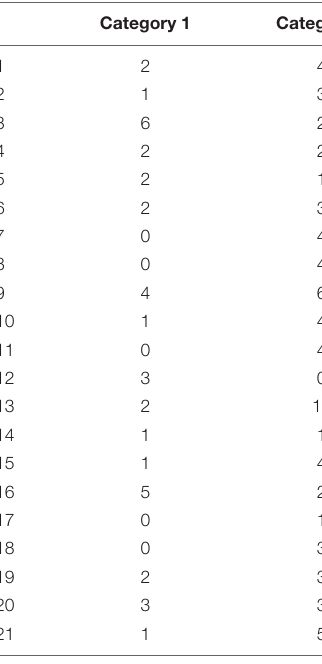
TABLE 3 | Frequency distribution of teachers’ conceptions of VRDW.